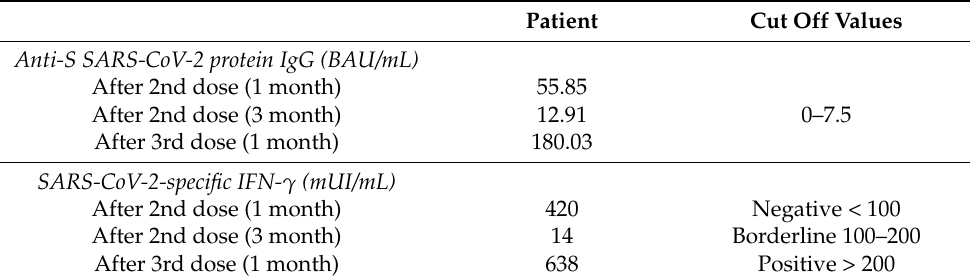
Table 2. Humoral and cellular responses to the SARS-CoV-2 vaccine in the CVID patient. We made the measurements one month and three months after the second dose of the vaccine and one month after the booster